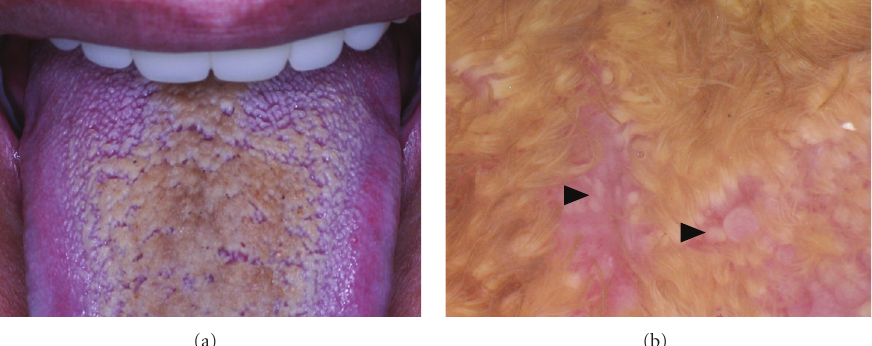
Figure 2: (a) Black hairy tongue on the dorsum of the tongue (Case 2). (b) Numerous brownish hair-like elongation of filiform papillae covering over whitish lingual papillae ( (cid:2) ) (Case